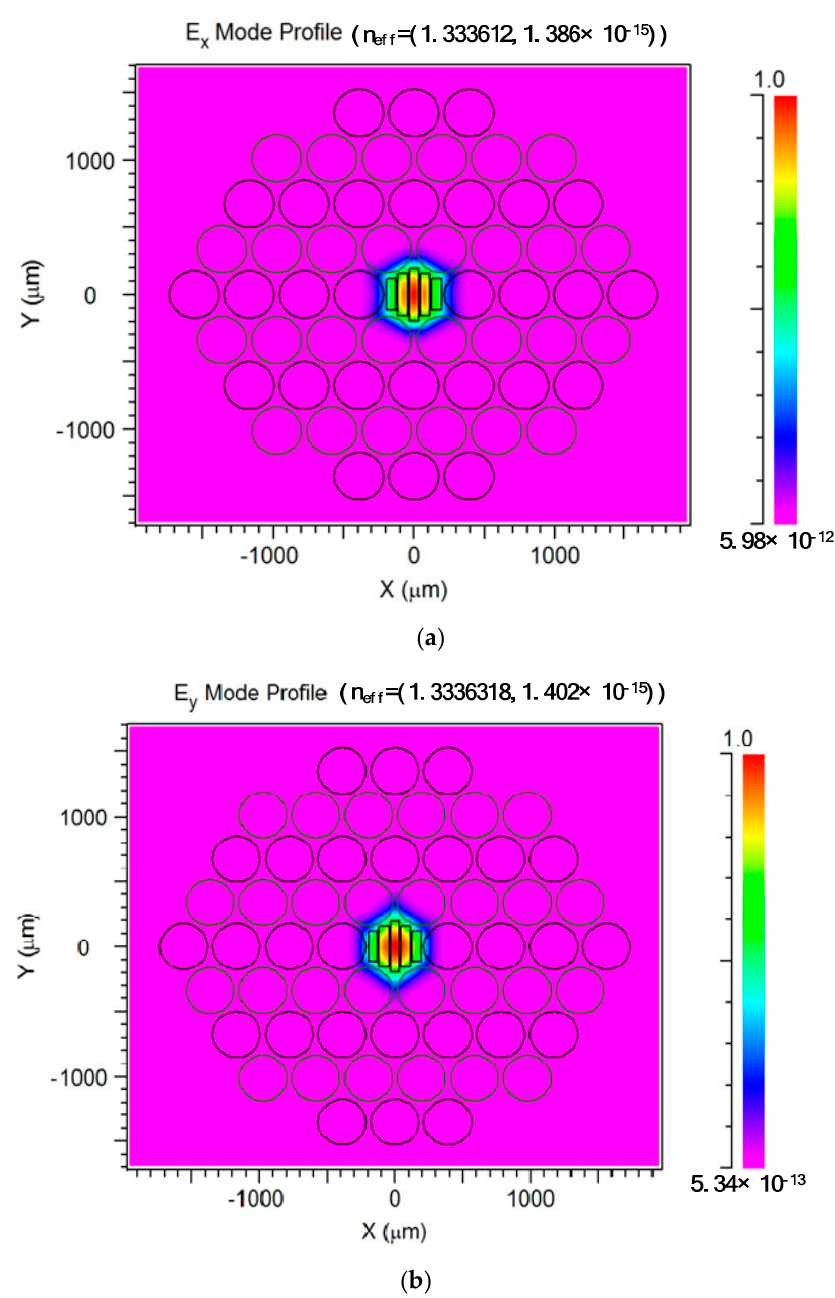
Figure 11. Mode field distribution of x- ( a ) and y-polarization ( b ) for the suggested TOPAS ® -based THz sensor. The circles are a cross-section of the air holes in the cladding.